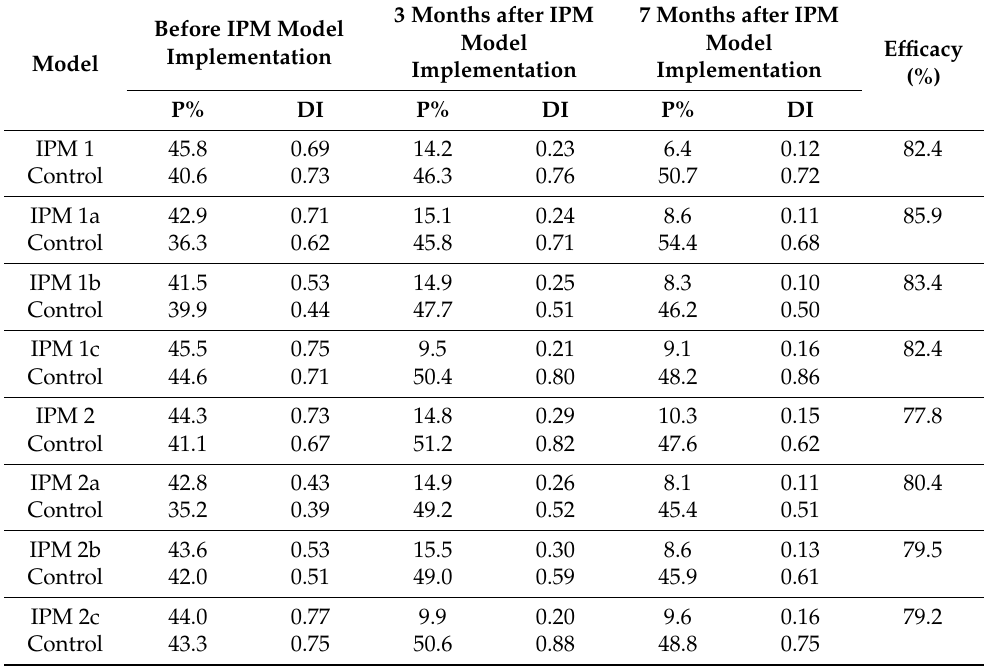
Table 8. Effect of the implementation of integrated pest management on damage incidence (P%) and damage index (DI).